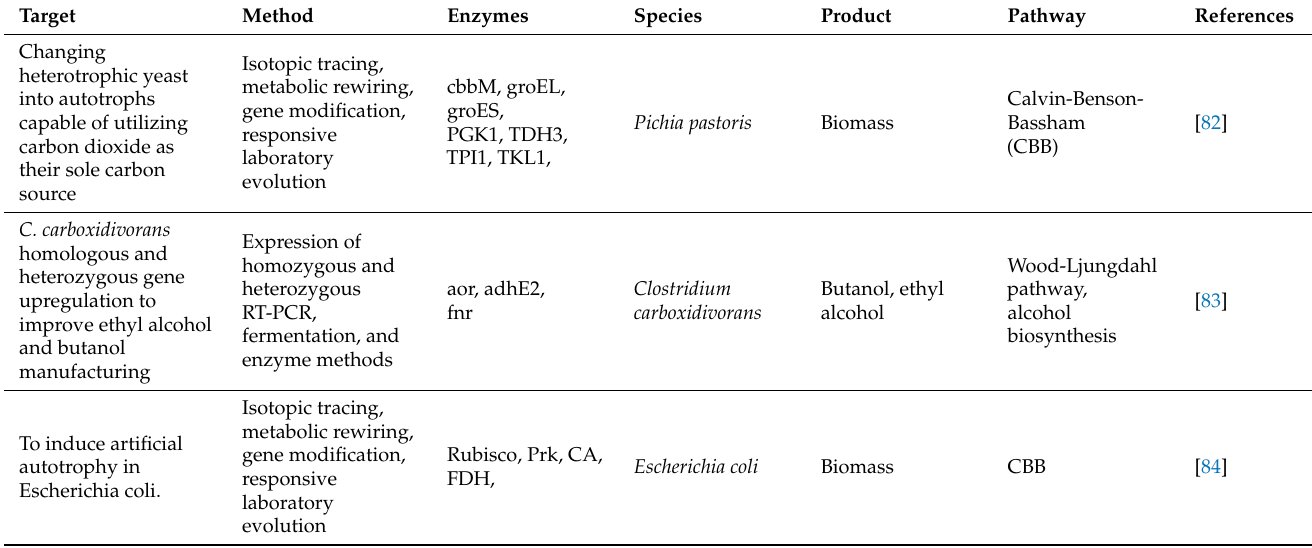
Table 1. Some biological control applications for carbon dioxide stabilization and bioconversion into renewable